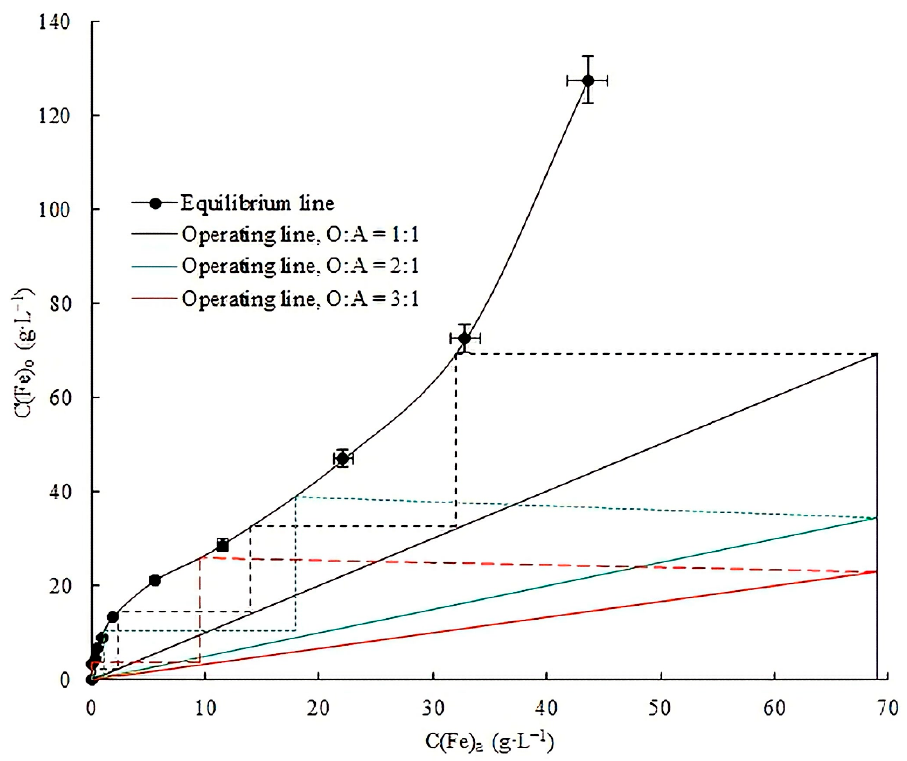
Figure 9. McCabe-Thiele plot for iron extraction. C(Fe 3+ ) a = 69.1 g·L − 1 , t = 20 °C, τ = 5 min. To reduce the number of extraction stages, the ratio O:A = 3:1 was used at two stages. The concentration of some metals in the initial solution and in the raffinate, and the logarithm of the distribution coefficient of metals during extraction, are shown in Figure 10. The concentration of iron in the aqueous solution decreased from 67.4 to 0.001 g · L − 1 . phase. It can be assumed that the low co-extraction of impurities is associated with a high concentration of iron in the initial solution. As a result, iron displaces non-ferrous metals already at the extraction stage. Thus, after two extraction stages, a raffinate was obtained containing g · L − 1 : Fe—0.001, Al—3.14, Ca—4.70, Mg—5.50, and Ni—1.35. The resulting solution is directed either to the slag leaching stage or to further processing to extract the remaining non-ferrous